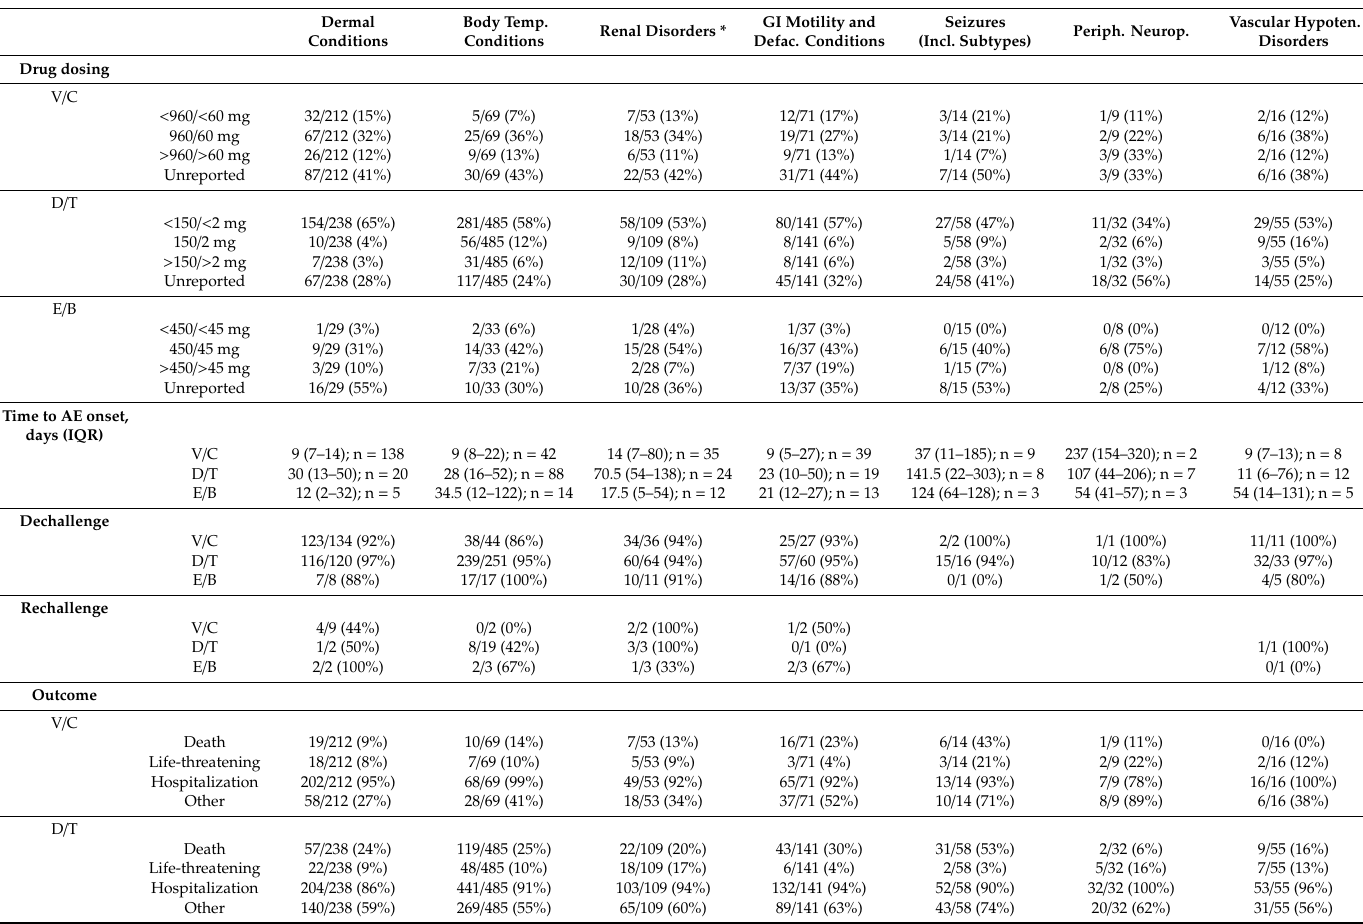
Table 3. Clinical characteristics of patients with selected serious adverse